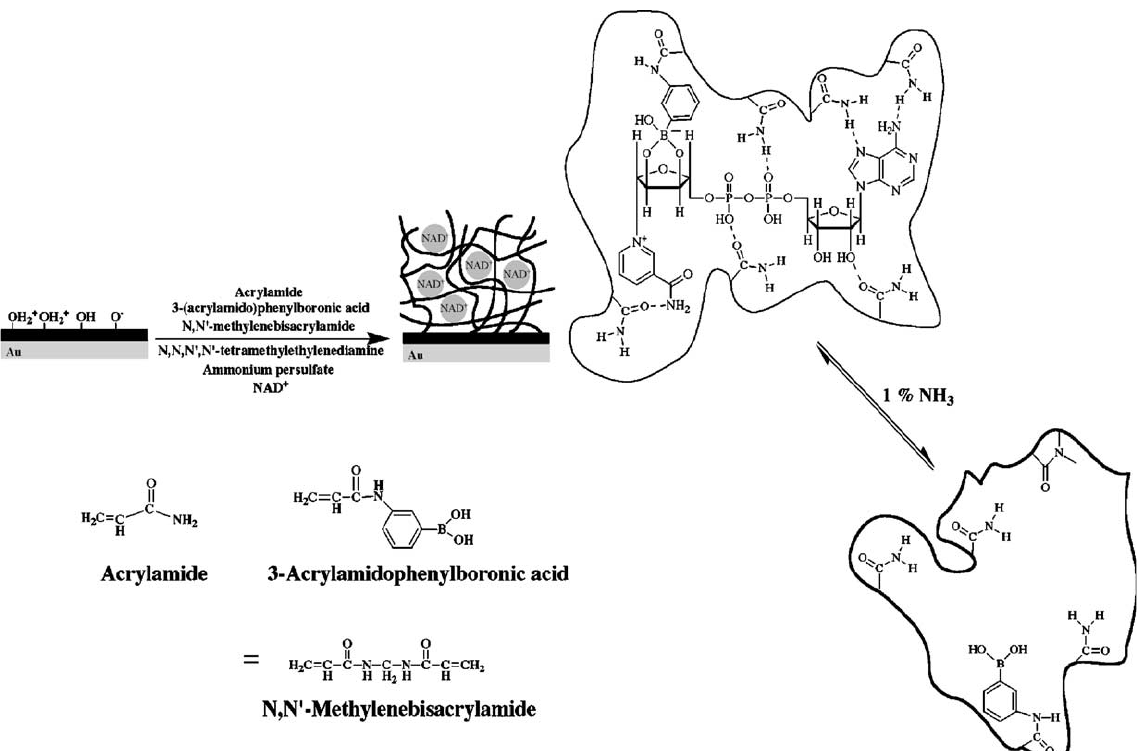
Figure 6. NAD(P)+/NAD(P)H cofactors-imprinted hydrogel with an acrylamide- acrylamidophenylboronic acid copolymer on an Au-coated glass for SPR-based detection. (Reproduced with permission from